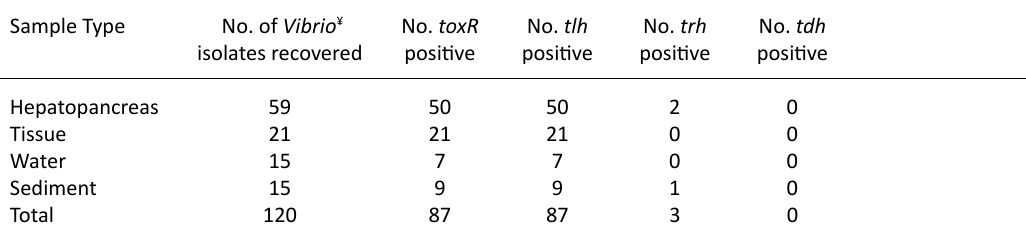
table 2. Details of the total (and pathogenic Vibrio parahaemolyticus isolated from shrimp, water and sediment samples